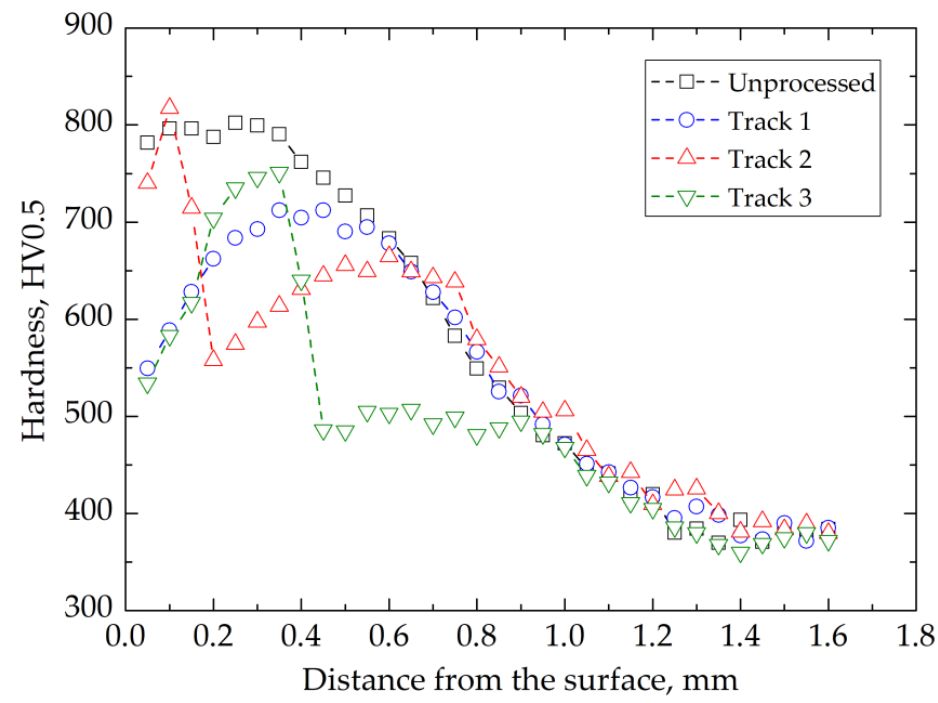
Figure 7. Hardness distribution of the carburized AISI 9310 steel in the tracks created by laser heating as a function of distance from the surface. Table 5. Volume fraction of retained austenite in unprocessed areas of the carburized AISI 9310 steel in tracks 1 ÷ 3 produced by laser surface heating.